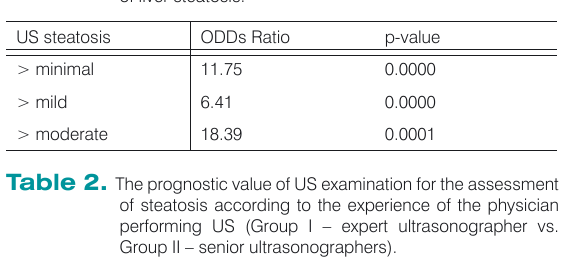
Figure 1. The etiology of chronic liver disease in patients with steatosis in which LB was performed.